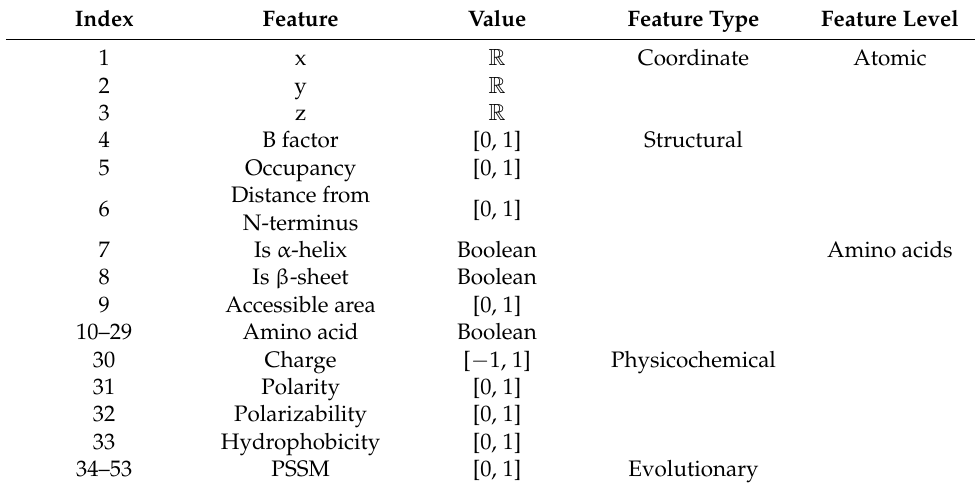
Table 3. Features assigned to each point in the point